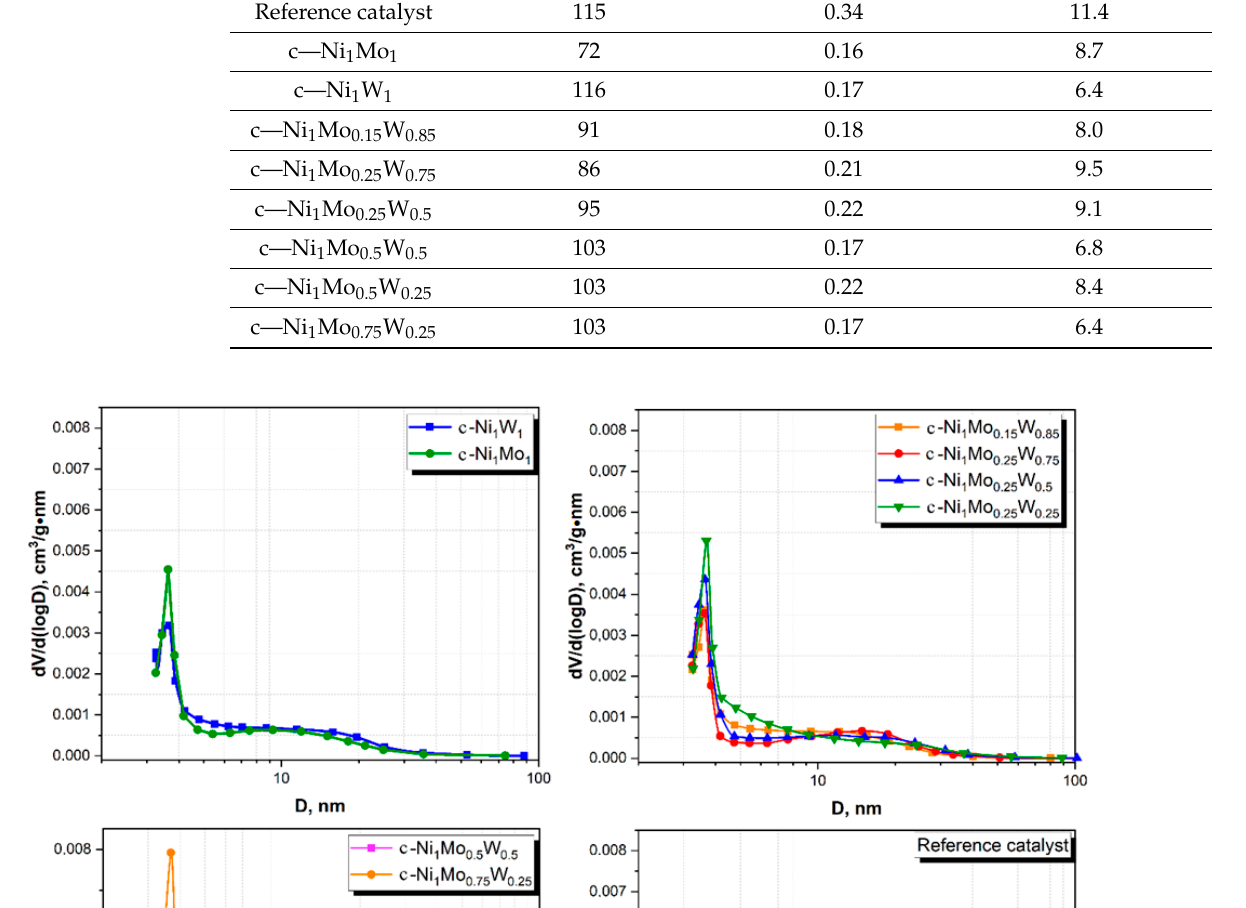
1 Mo 1 , c—Ni 1 W 1 , and c—Ni 1 Mo x W y